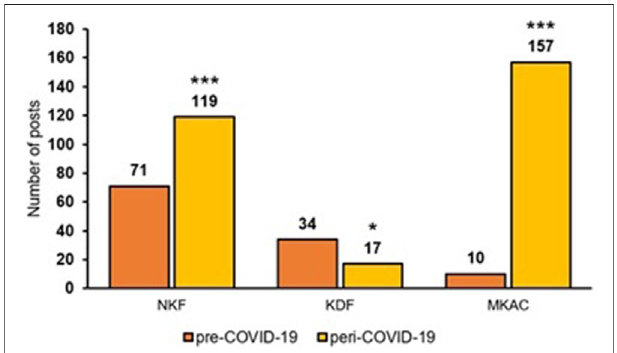
FIGURE 1 | Number of posts by the SSAs in pre-COVID-19 and peri- COVID-19. *: p -value ≤ 0.05; ***: p -value ≤ 0.001.